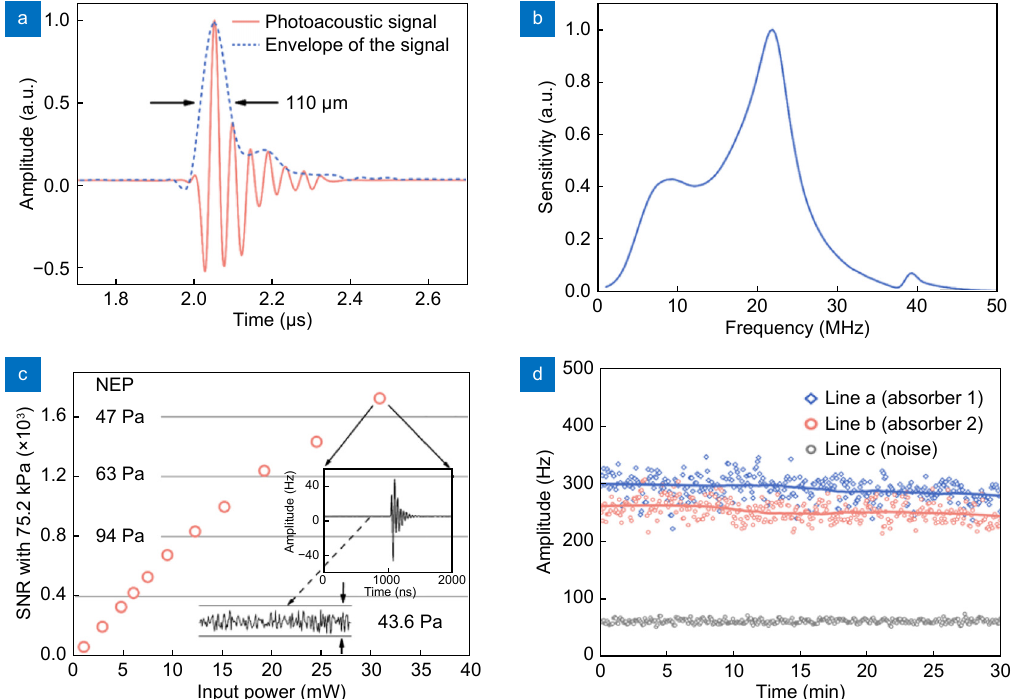
Fig. 4 | ( a ) Temporal and ( b ) frequency response of the sensor. ( c ) Measured NEP as a function of input power at the photodetector. ( d ) Stability test result by continuously measuring the photoacoustic signals from two discrete absorbers over 30 min. Figure reproduced with permission from ref. 31 , Optical Society of